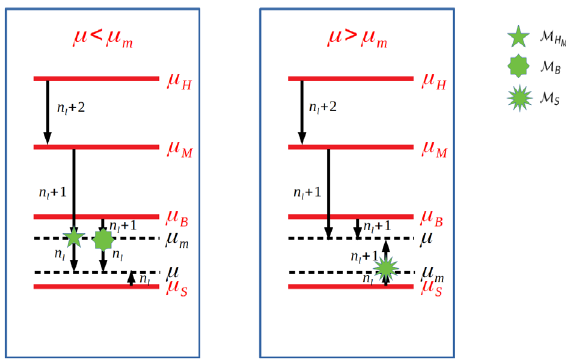
Figure 3: Consistency condition for scenario b . Both running setups must yield the same